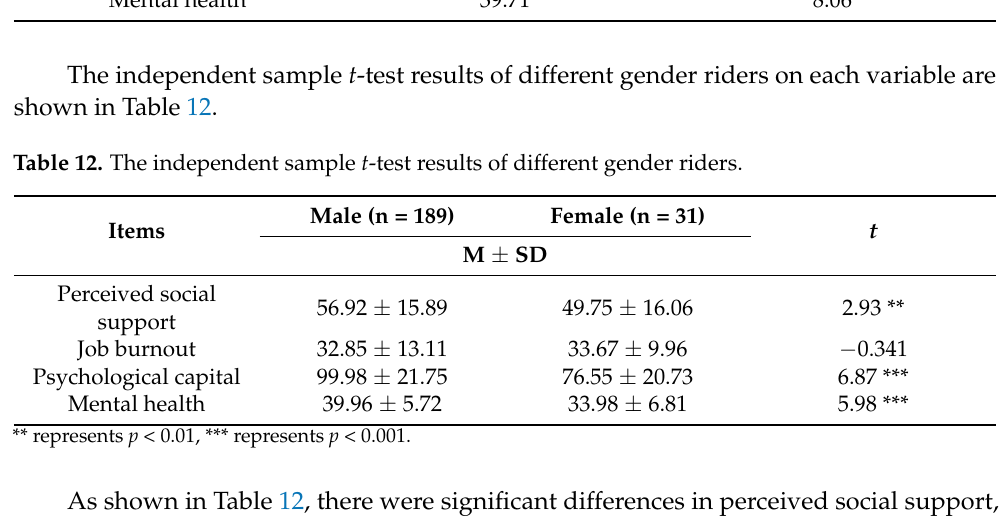
Table 11. The descriptive statistical results of research variables. Items Perceived social support